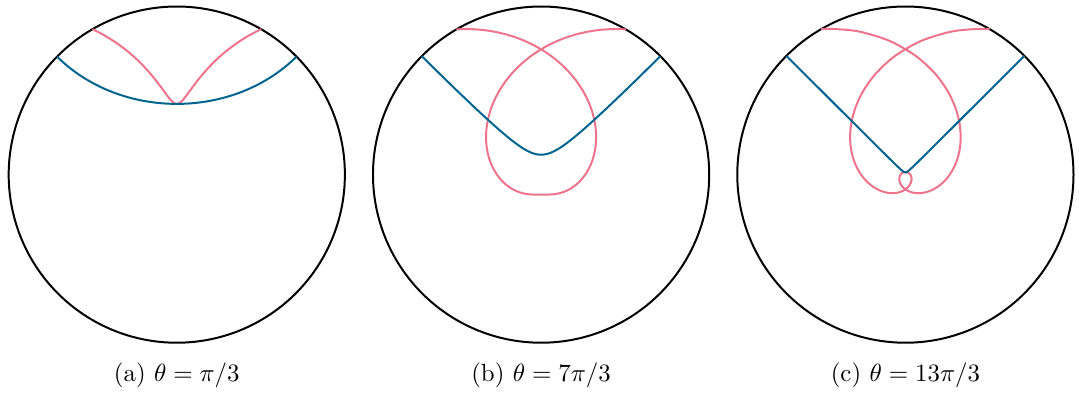
Figure 4 . Example of solutions to the equations of motion with nontrivial windings for φ = π/ 2 and θ = ( π/ 3 mod 2 π ) . The radial direction is (1 + t 2 ) − 1 / 2 , with the black circle corresponding to the conformal boundary. The blue curve is ϕ ( t ) and the red curve is ϑ ( t )